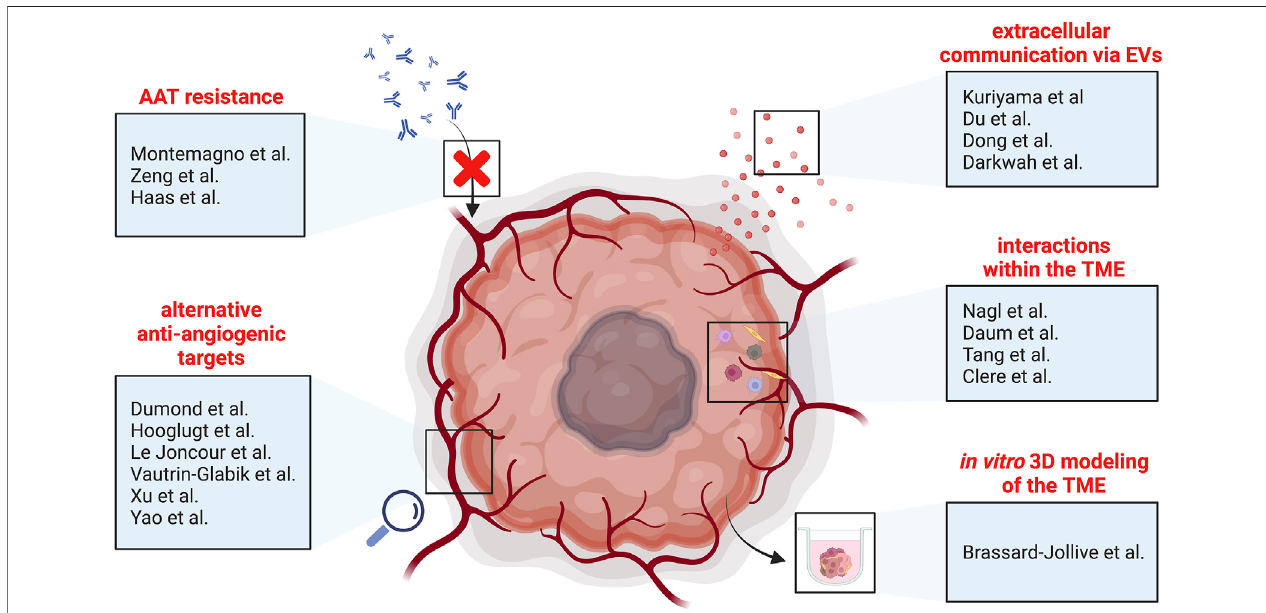
FIGURE1 | Schematic overview of thedifferent topics covered by this special research topic of “ Tumor Vesselsas Directors of the Tumor Microenvironment: New Findings, Current Challenges & Perspectives ” . AAT, anti-angiogenic therapy; EVs, extracellular vesicles; TME, tumor microenvironment.